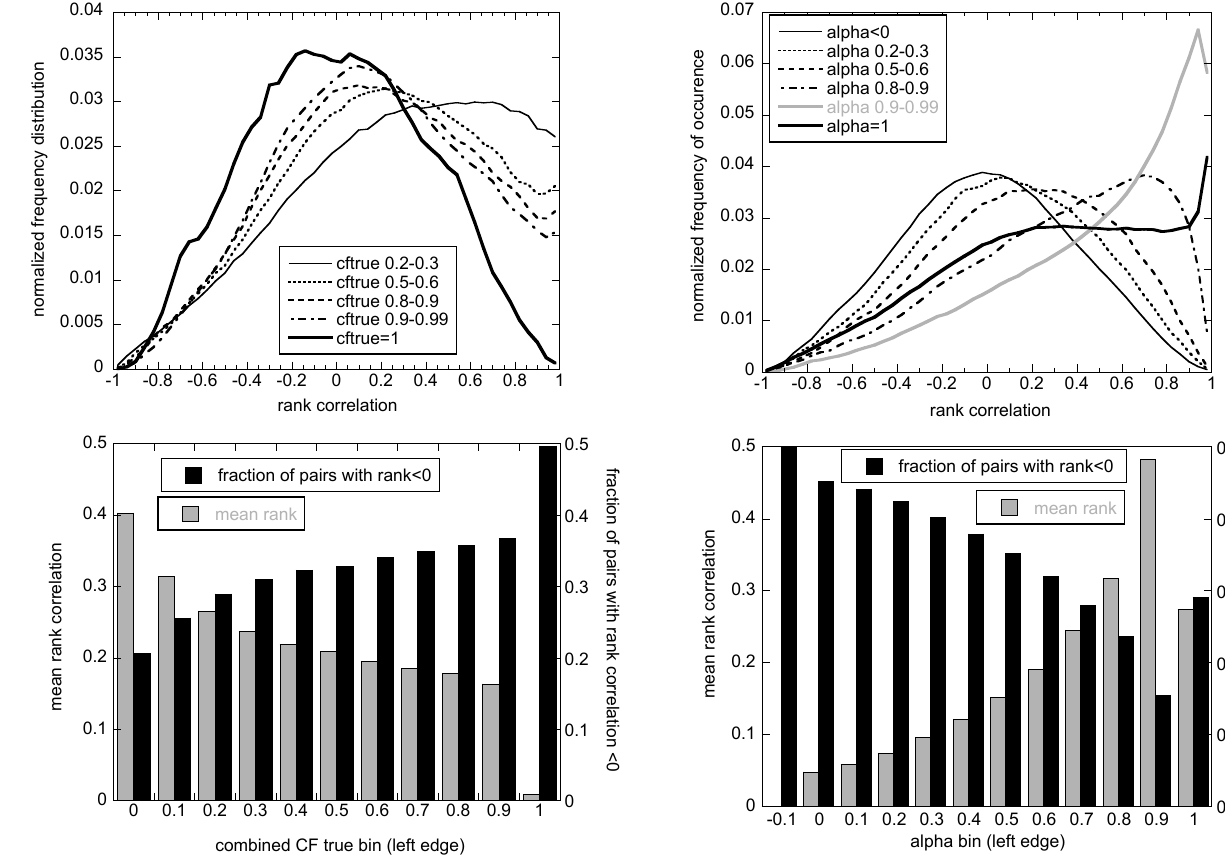
Fig. 6. (top) histograms of rank correlations for different bins of true combined cloud fraction calculated from layer pairs taken at every possible separation distance within 150km segment sizes; (bottom) ensemble-averaged rank correlations and fraction of negative rank correlations within true combined cloud fraction bins from the same dataset used for the top panel. The x-axis labels in the lower panel indicate the left edge of the bin. For example 0.1 refers to the in- terval [0.1, 0.2), and the last bin is for a combined cloud fraction exactly equal to 1.